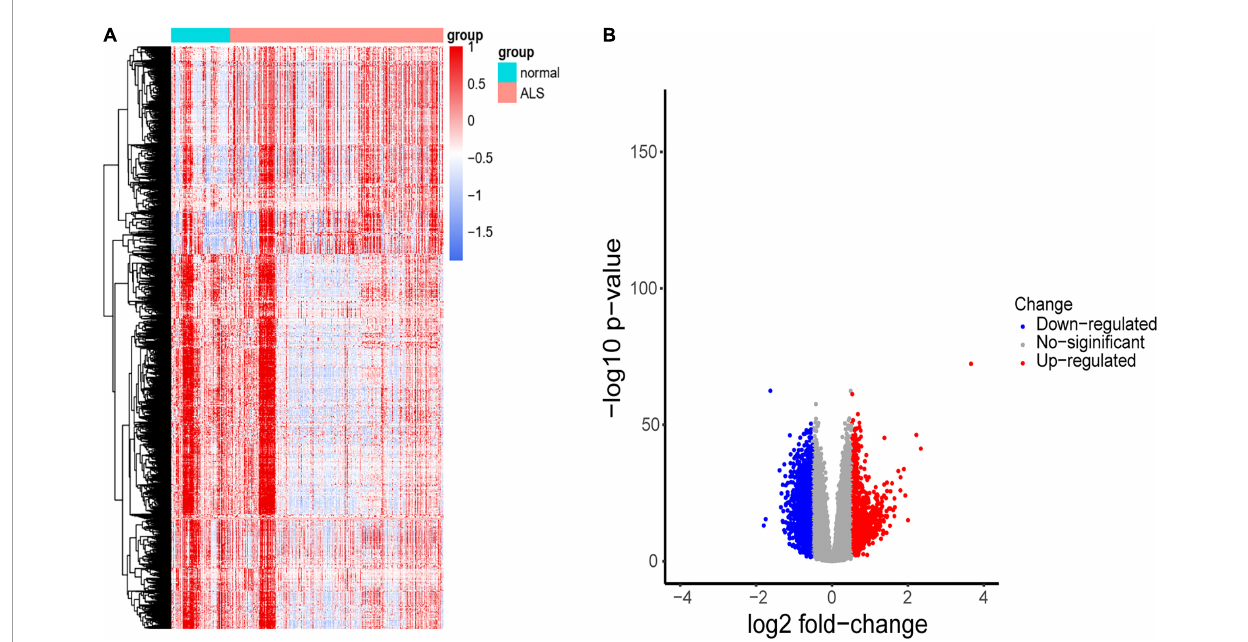
FIGURE2 Identification of DEGs between ALS cases and non-neurological controls. (A) Heatmap profiling of the genes enrichment analysis between ALS patients and non-neurological controls. (B) Volcano plot of DEGs between ALS patients and non-neurological controls. Blue dots represent downregulated genes (1,767 genes), red dots represent upregulated genes (987 genes), and gray dots represent no significantly differentially expressed genes (17,249